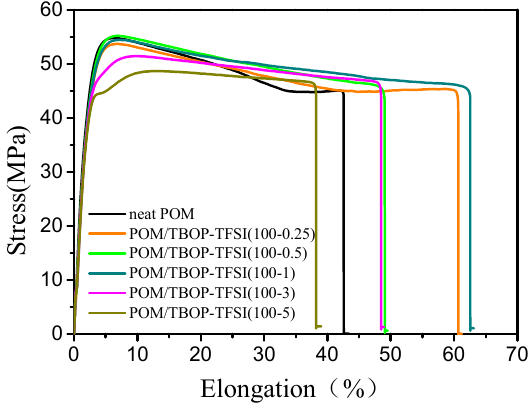
Figure 5. Stress-elongation curves of POM/TBOP-TFSI composites. Table 2. Mechanical properties of POM/TBOP-TFSI composites.